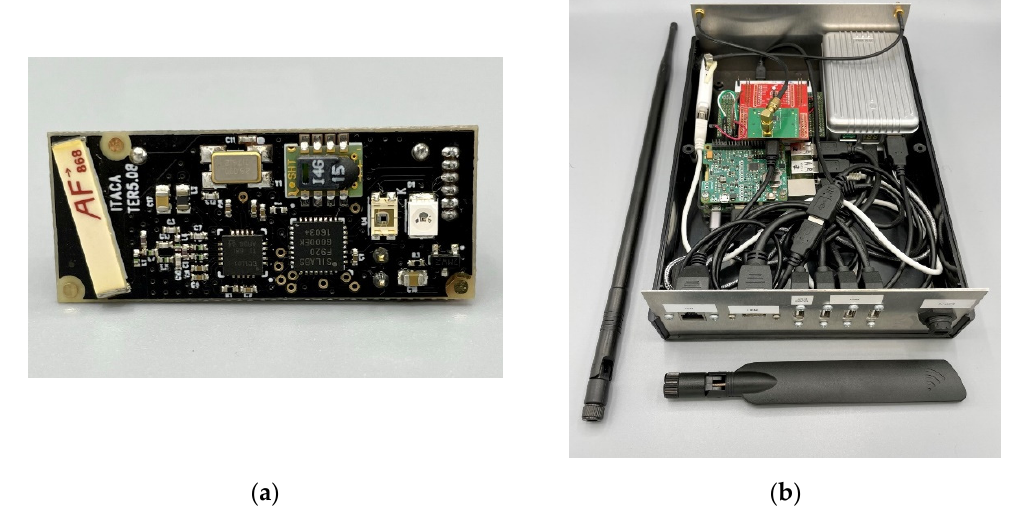
Figure 2. Key components of the electronics associated to the monitoring system: ( a ) wireless sensor node with a size of 4 cm × 1.5 cm × 1.5 cm, ( b ) custom gateway designed specifically for the monitoring needs in cultural heritage sites.